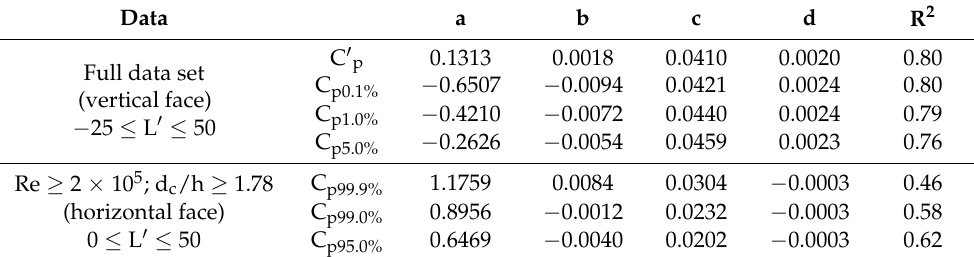
Figure 7. Streamwise development of the mean (left) and fluctuating (right) pressure coefficients, at the LOH II stepped chute: ( a , b ) vertical face of the step, near the outer edge (z/h = 0.133); ( c , d ) horizontal face of the step, near the outer edge (y/l = 0.178). Table 3. Coefficients of Equation (7) relative to the outer edge of the vertical and horizontal faces of the